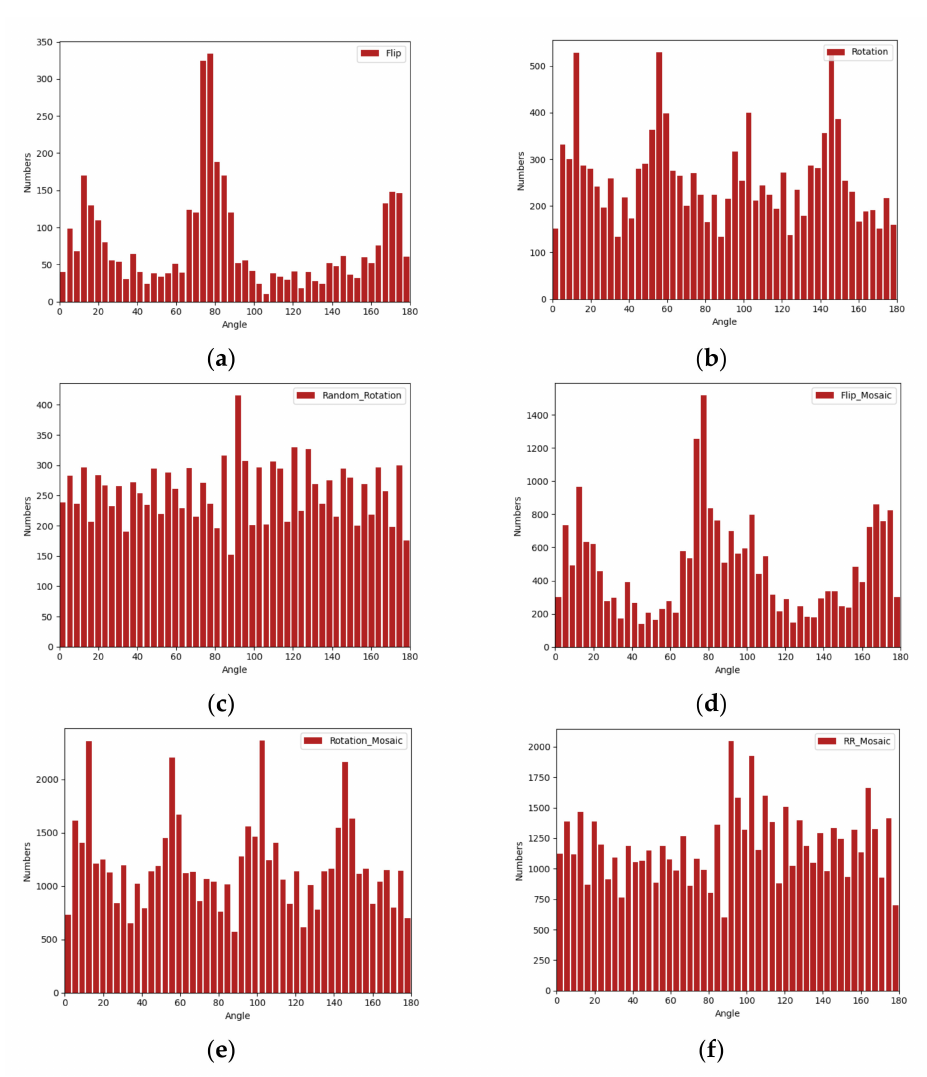
Figure 9. Distributions of the angle on SSDD with different data augmentation methods. ( a ) Flip. ( b ) Rotation. ( c ) Radom Rotation. ( d ) Flip Mosaic. ( e ) Rotation Mosaic. ( f )